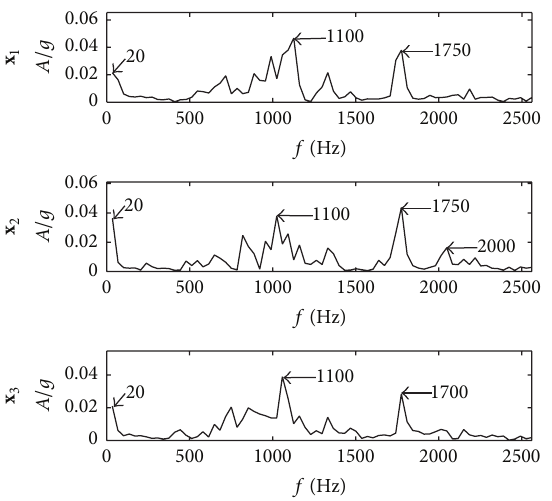
Figure 9: Spectrums of separated